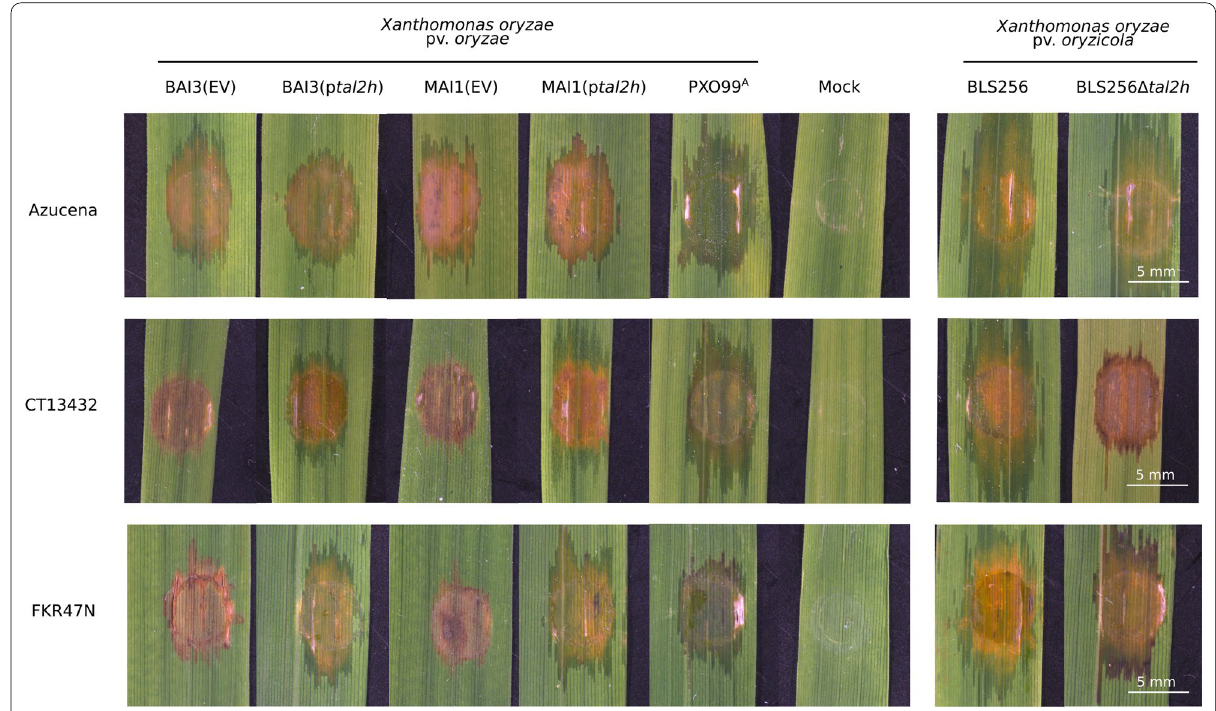
Fig. 2 The resistance of CT13432 and FKR47N against African Xoo is largely suppressed by a truncTALE. Leaves of CT13432 and FKR47N rice varieties were inoculated with Xoo strains BAI3 and MAI1 carrying an empty vector (EV) or the truncTALE tal2h as well as Xanthomonas oryzae pv. oryzicola ( Xoc ) strain BLS256 which is naturally carrying tal2h and the mutant strain BLS256Δ tal2h . The susceptible rice variety Azucena and the Asian Xoo strain PXO99 A were used as controls. Leaves were photographed at 5